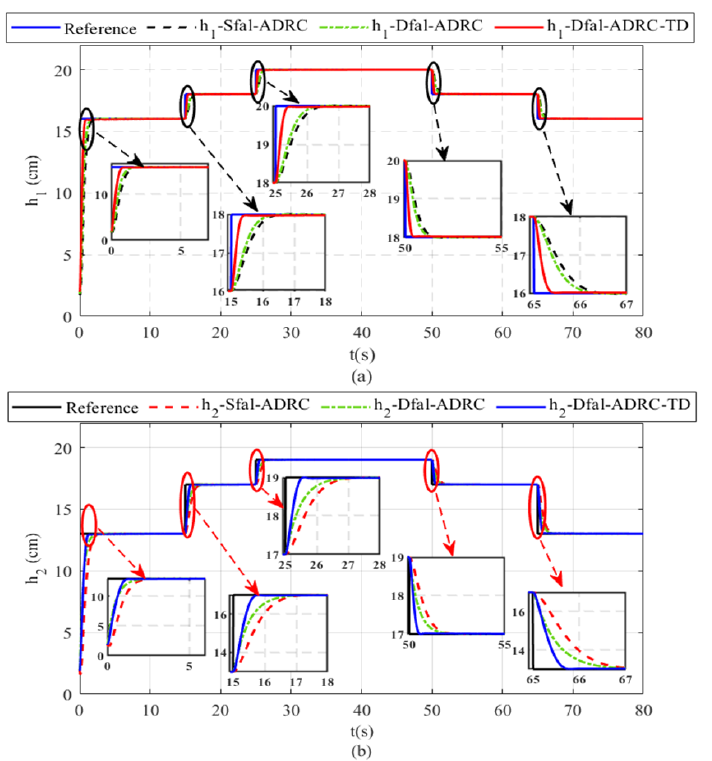
Figure 10. The water level under different time-varying references using the 2 nd MADRC scheme. ( a ) 1 st subsystem. ( b ) 2 nd subsystem.